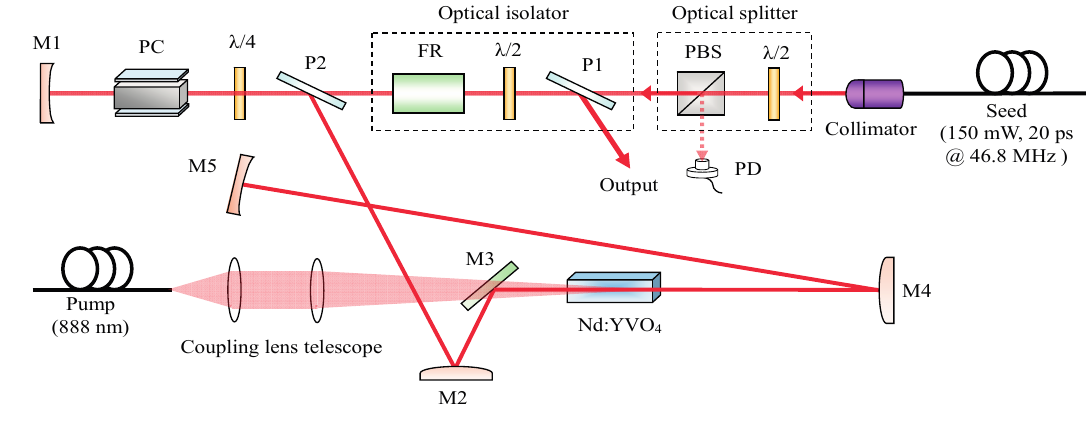
Figure 1. Design scheme of the fiber laser pumped regenerative